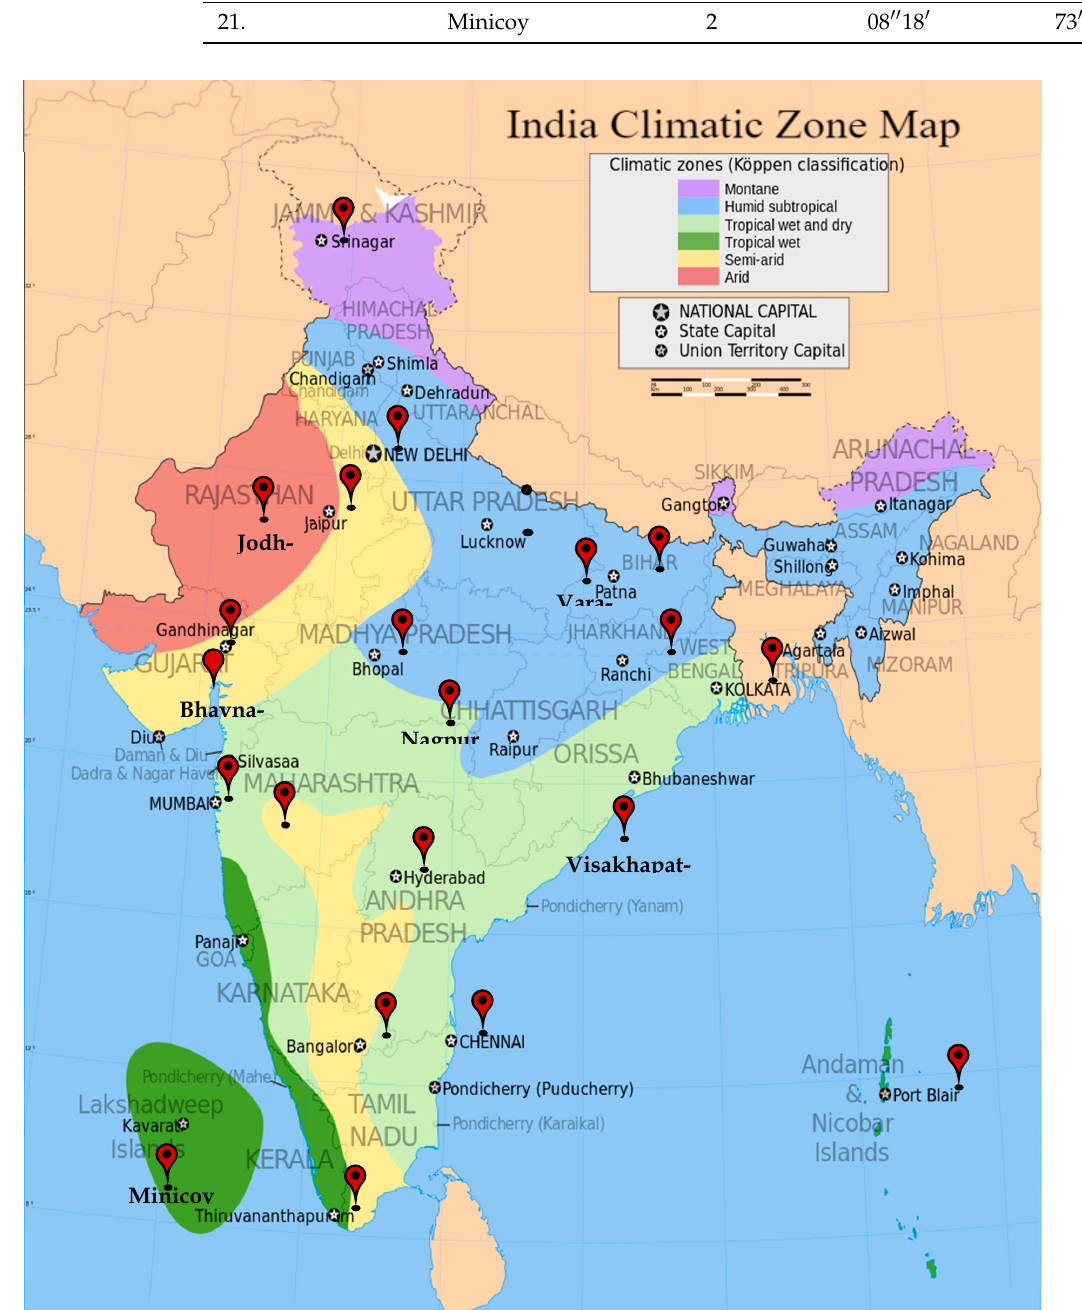
Figure 1. Indian meteorological stations, 21 of which are geographically located. Table 1. Geographical coordinates of the designated cities.